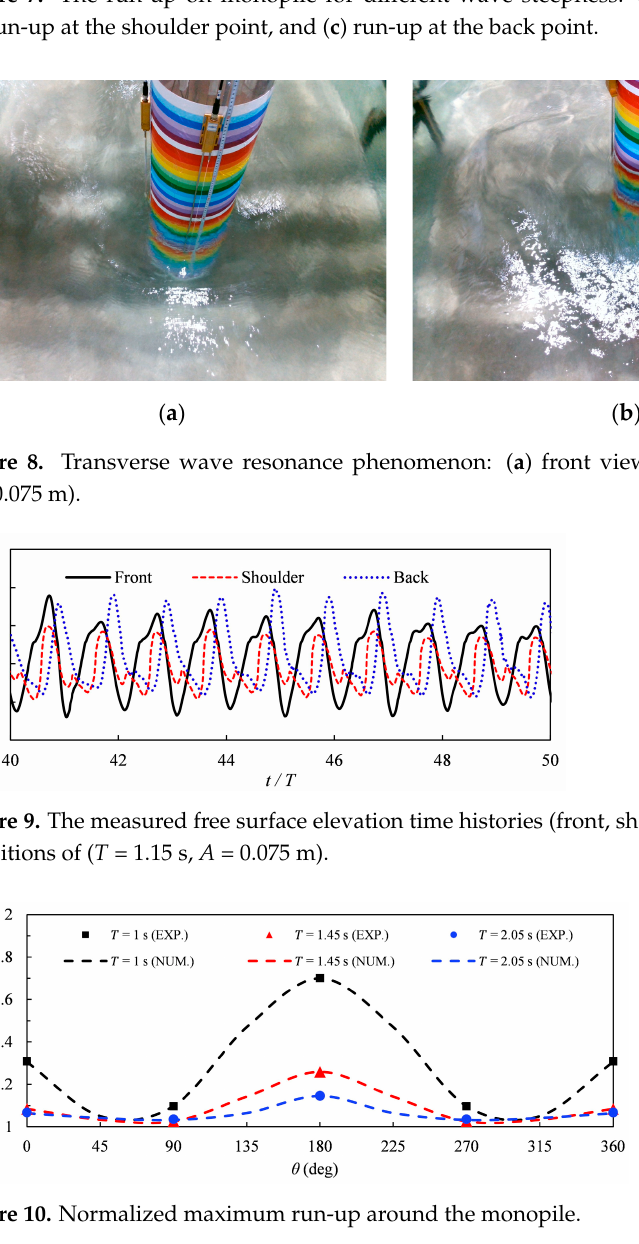
( b ) Figure 11. Variation of harmonics with the wave steepness kh: ( a ) linear force component; ( b ) second- harmonic forces.